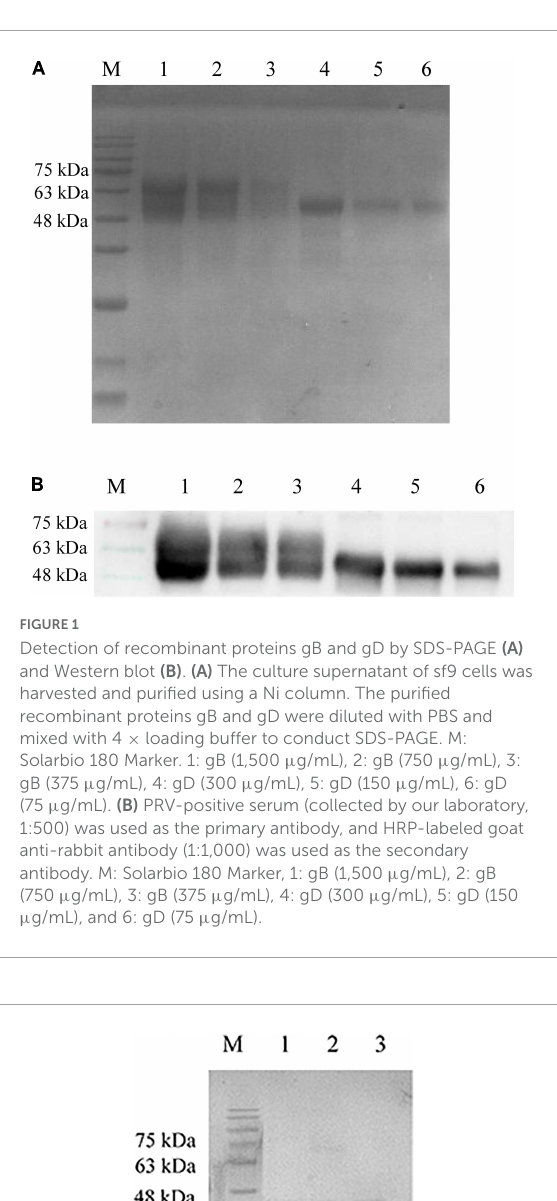
respectively. GM-CSF expression values were calculated at a mass for 35 kDa ( Figure 2 ), and the concentration of GM- CSF was 2